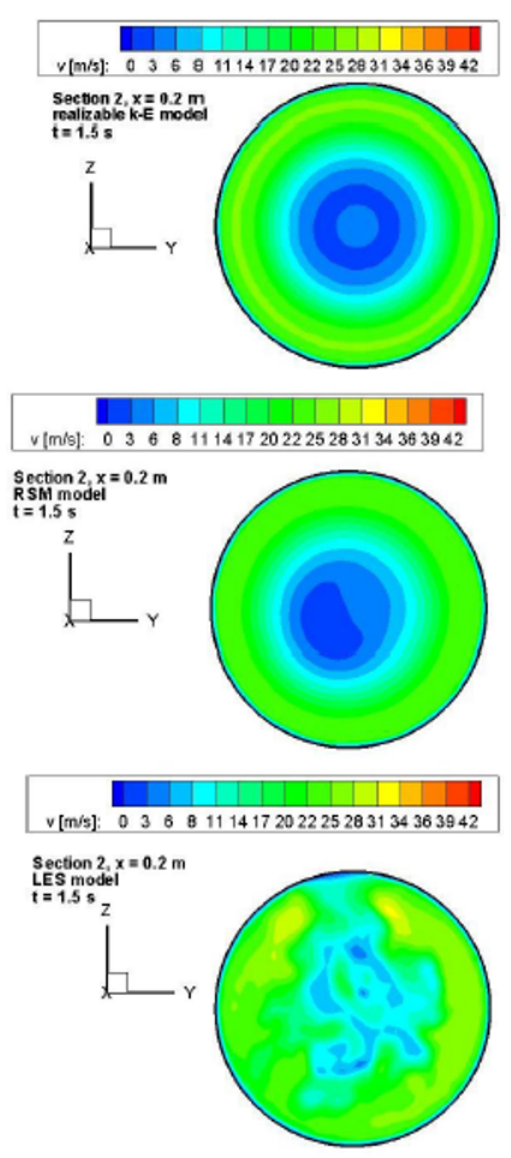
Figure 9. Velocity distribution along the chamber axial cross-section for the three turbulent models for t=1 s. Figure 7. Velocity field distribution in section 2 for the three turbulent models for t=1.5 s. The results obtained with the three turbulence model are much alike, in terms of the prediction of the extent of the value of the velocity in the recirculation region, it is pos- recirculation region. The extent and shape of the recircu- sible to determine the minimum required velocity for the lation region is similar for the first two turbulence models. carburant gas which has to be injected in the combustion chamber. For this reason, the extent of the recirculation region was investigated. To achieve this, the distribution of the velocity along the axial cross-section of the combus- tion chamber was plotted (Fig. 8 to Fig. 10). The velocity distribution for three different time steps is plotted in order to see if there are changes in the velocity field over time.